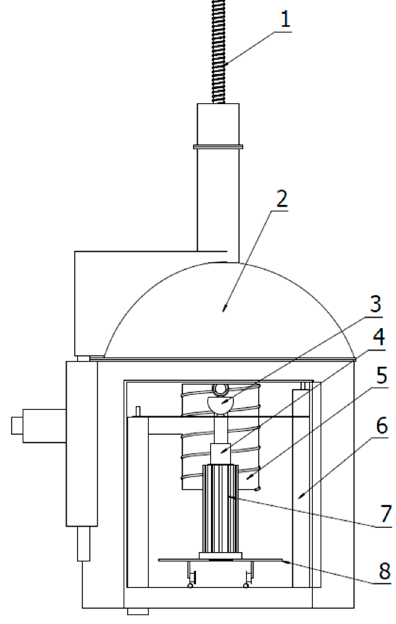
Figure 1. Schematic view of vacuum melting casting system: 1, stirring rod; 2, vacuum furnace; 3, flow groove; 4, feeder; 5, crucible; 6, frame; 7, permanent mold; 8, trolley.